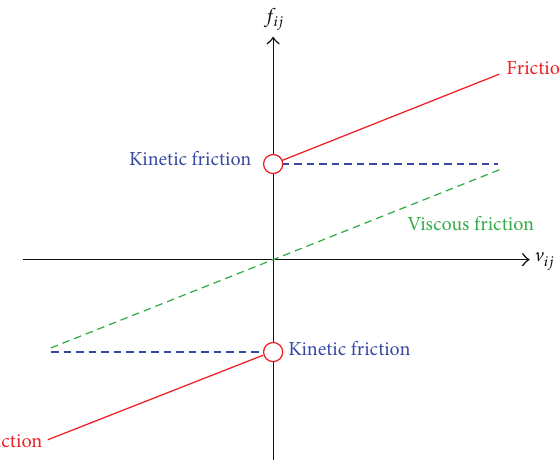
Figure 5: The diagram of the included friction model. 𝑓 𝑖𝑗 and V 𝑖𝑗 represent the friction force that generates the toe and the velocity of the toe, respectively. Blue line and green line represent the kinetic friction force and the viscous friction force, respectively. The composition of these two friction forces represents the actual generated friction force 𝑓 𝑖𝑗